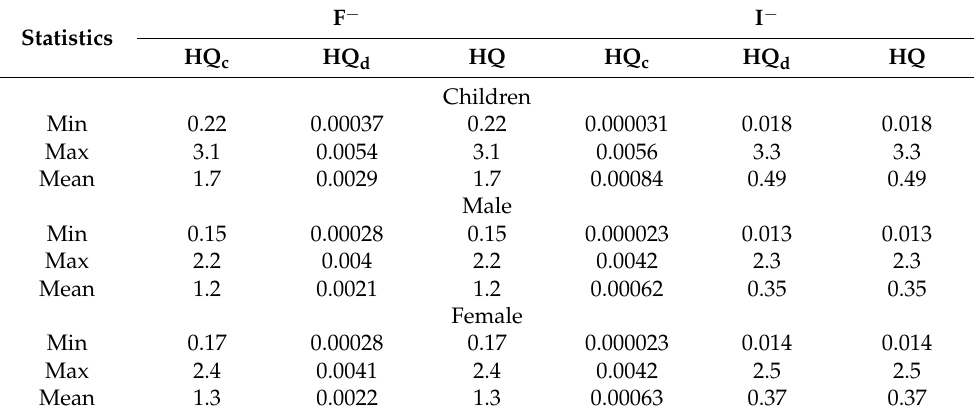
Table 5. Personal health risk values of typical pollutants in the deep